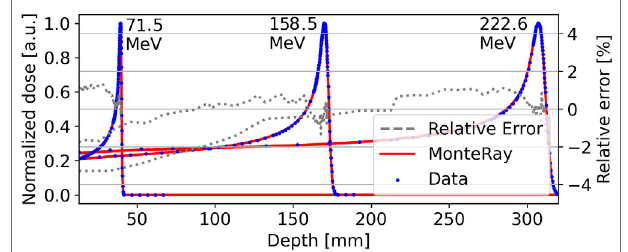
FIGURE 2 | Integrated depth-dose pro fi les of quasi-monoenergetic beams with energies of 71 MeV, 158.5, and 222.6 MeV are shown. Peak fi nder measurements are indicated by blue points and MonteRay simulations as solid red lines. The relative error, after correcting for a lateral shift, between measurements and MonteRay simulations isshown with grey dotted lines after correcting for the lateral